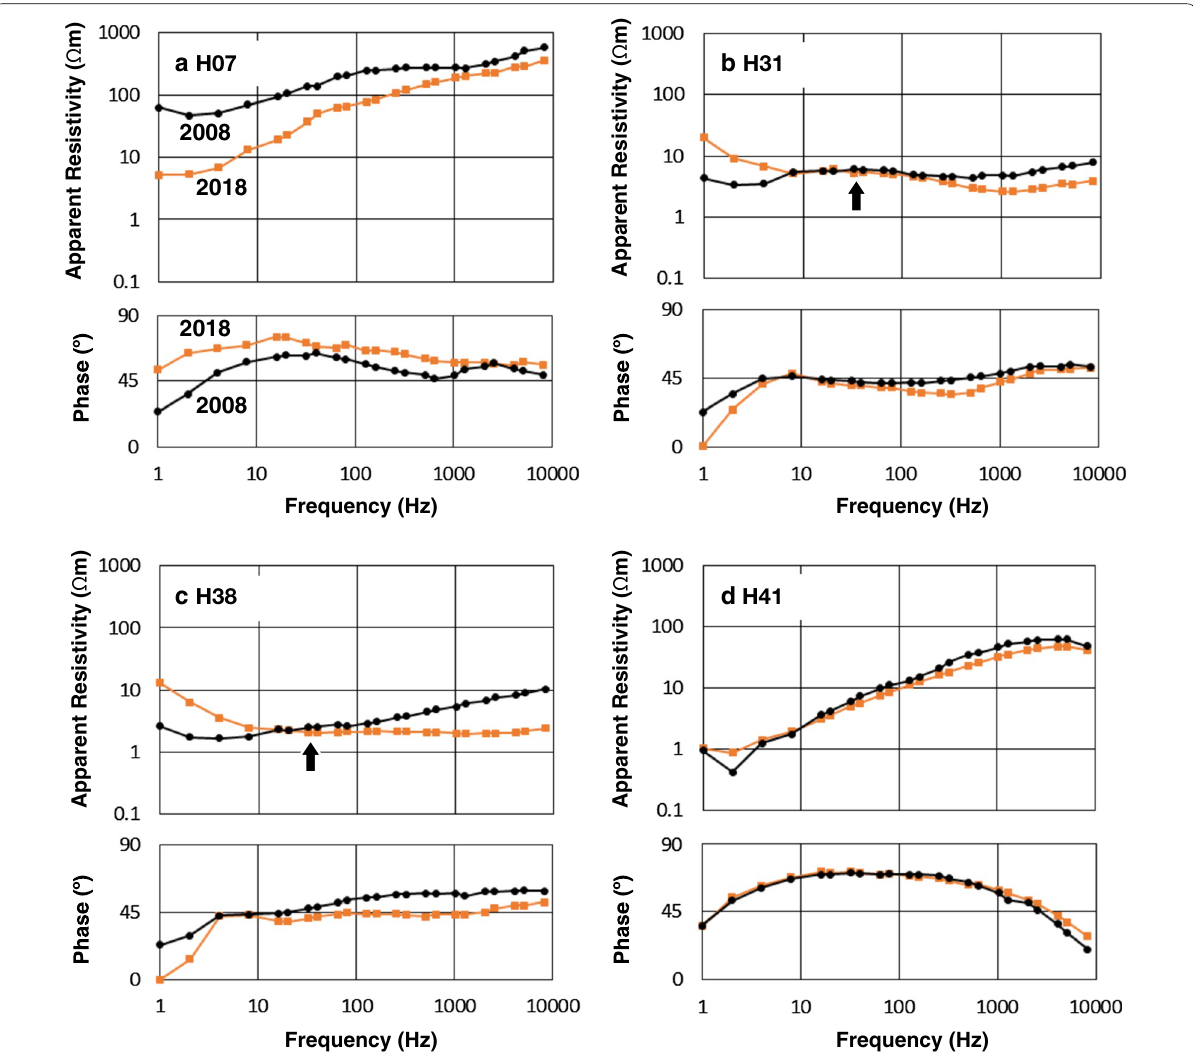
Fig. 7 Examples of CSAMT data from 2008 (black) and 2018 (orange) surveys at four locations on survey line Fa. Apparent resistivity (upper panel) and phase angle (lower panel) data are displayed as a function of the frequency at receiver Stations H07, H31, H38, and H41. H07 represents the stations above the conductive Region U. H31 and H38 represent the stations above the resistive Region P presented in Fig. 5. A significant change can be observed between the data from 2008 to 2018 at Stations H07, H31, and H38. Conversely, no significant change can be observed at H41. The slight increase in resistivity in the range of 10–100 Hz in H31 and H38 (arrow) indicates the existence of the shallow resistive Region